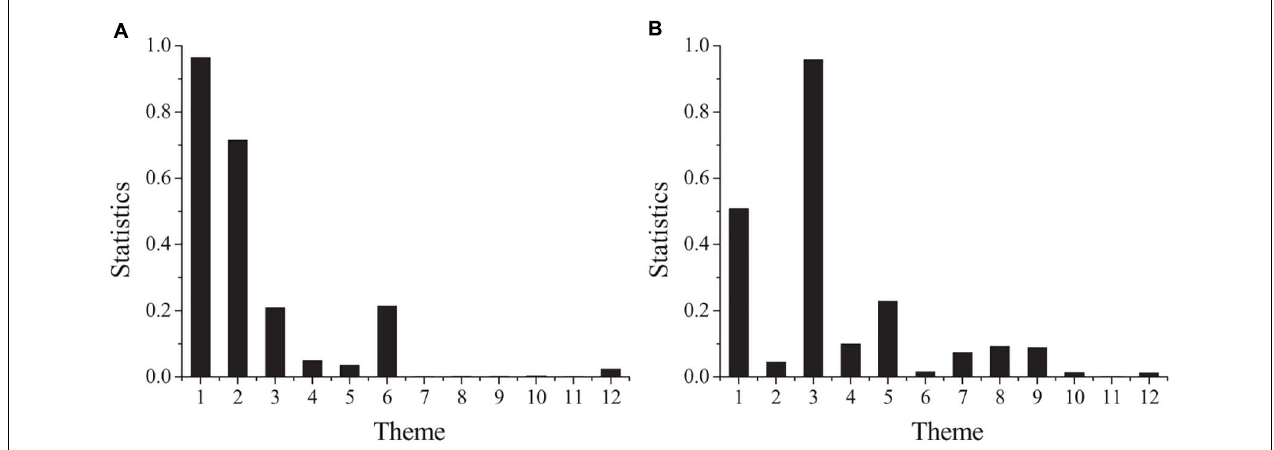
FIGURE 5 | The differences of psychological contract among employees with different working years ( A: the second part; B: the third part).